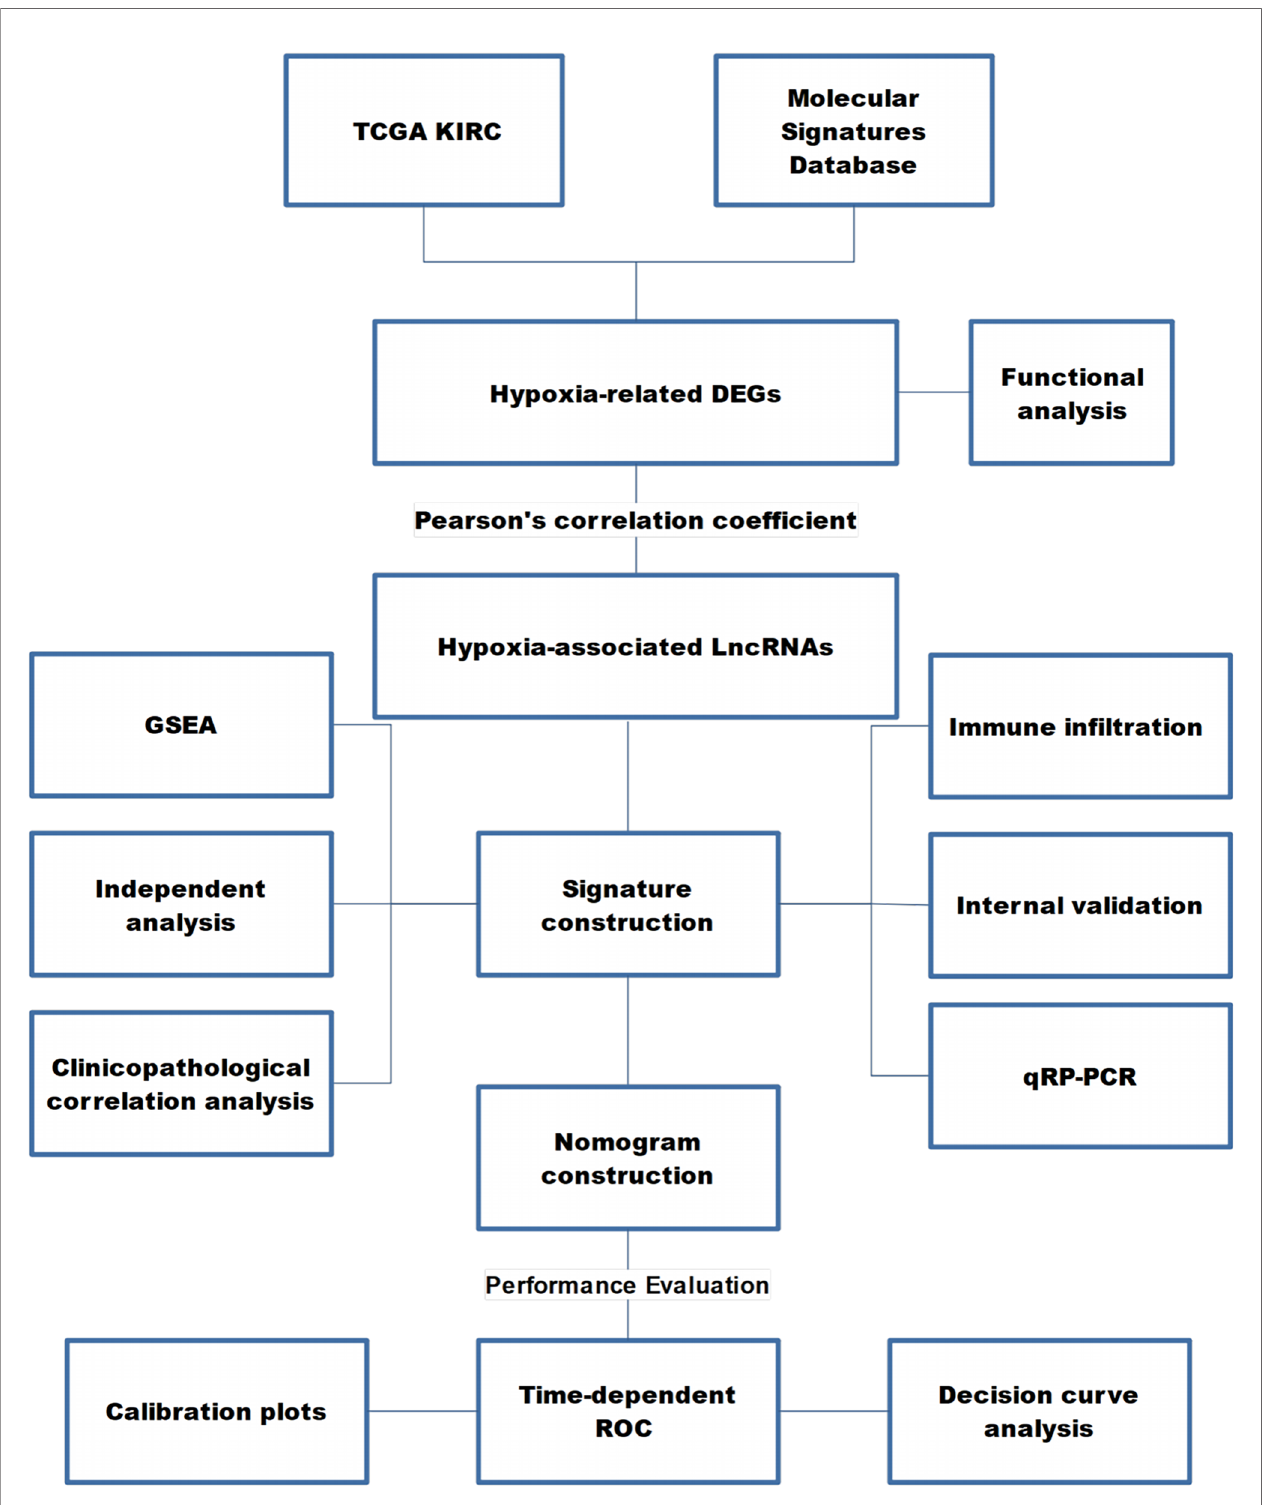
FIGURE 1 | The work fl ow of this study. TCGA KIRC, The Cancer Genome Atlas Kidney Renal Clear Cell Carcinoma; DEG, differentially expressed gene; LncRNA, long non-coding RNA; GSEA, gene set enrichment analysis; ROC, receiver operating characteristic curve.